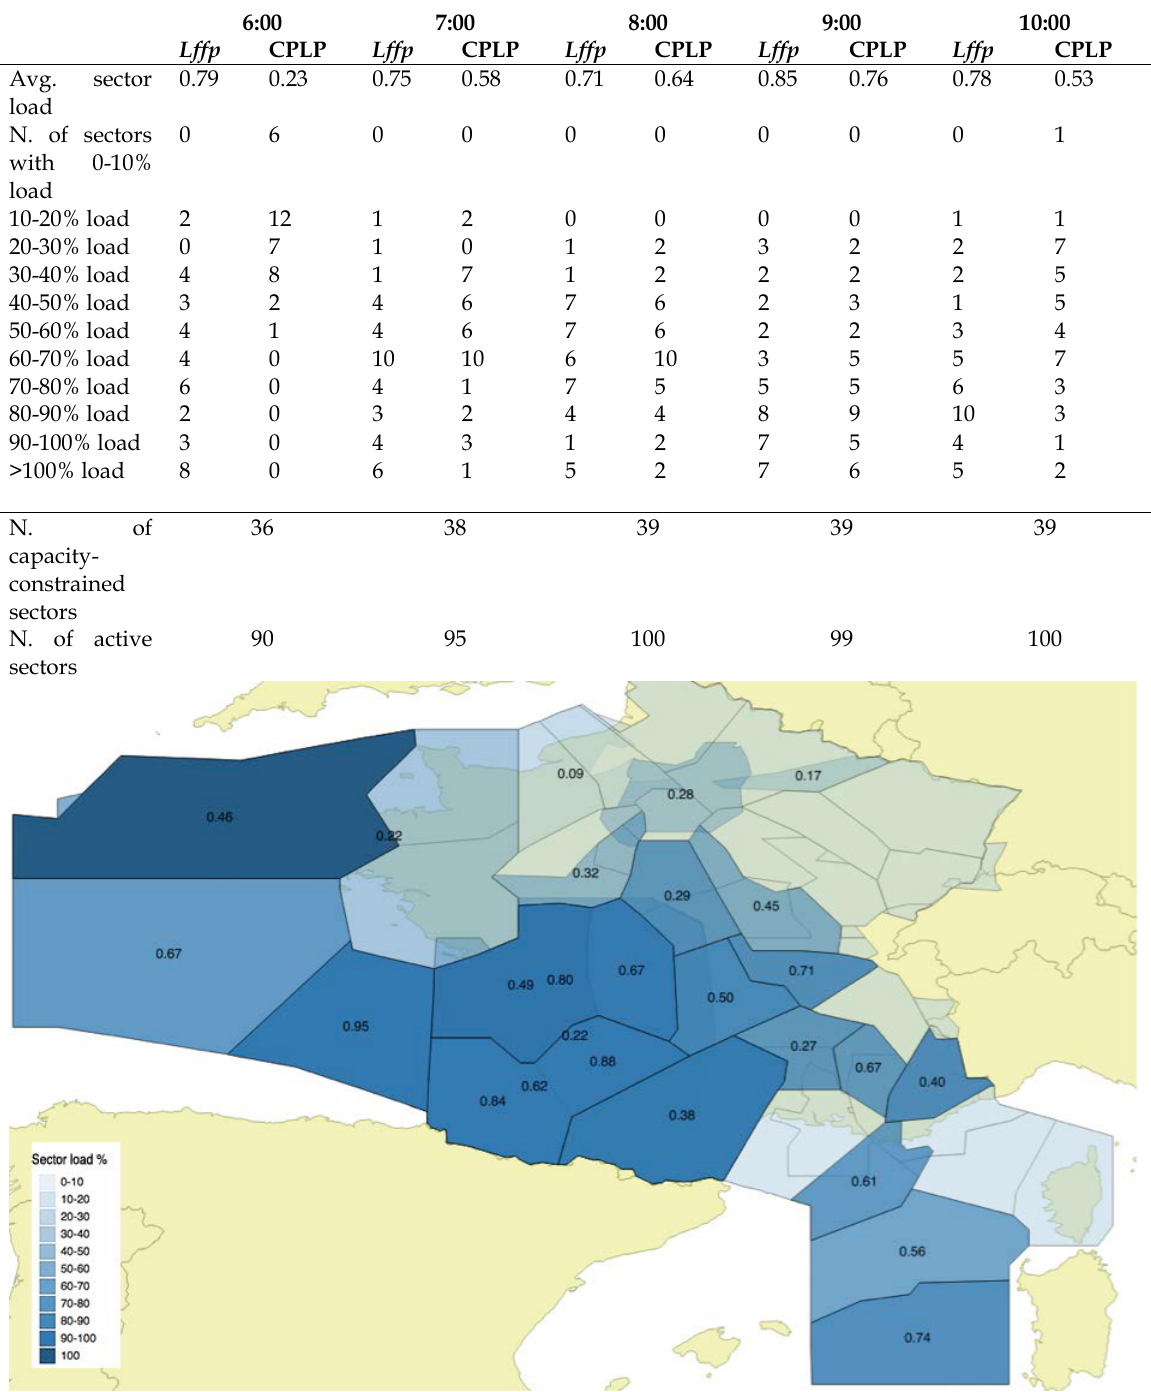
Figure 2. Load on capacitated active sectors at 10:00 on 12th September 2014 (with CPLP). Sectors with a darker colour have a higher